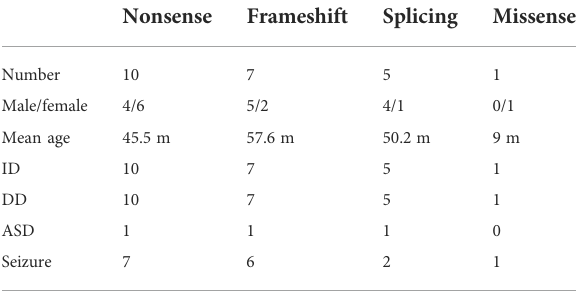
TABLE 3 Comparison of cardinal features in 23 Chinese